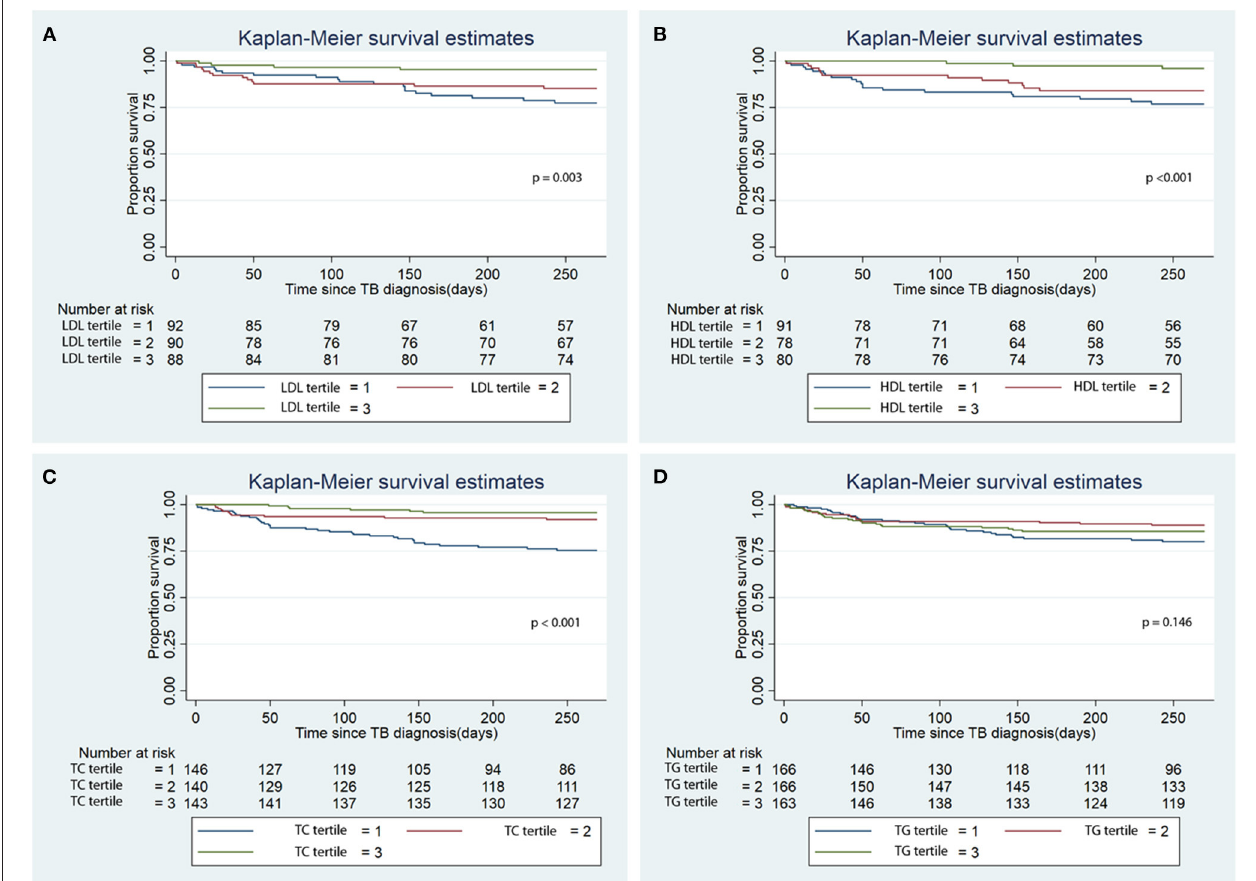
FIGURE 3 | Kaplan Meier analysis of the association of baseline serum lipid level tertiles with infection-related mortality. (A) Low density lipoprotein (LDL); (B) High density lipoprotein (HDL); (C) Total cholesterol (TC); (D) Triglycerides (TG). TB, tuberculosis. 3rd tertiles of LDL and TC compared to the 1st tertiles of